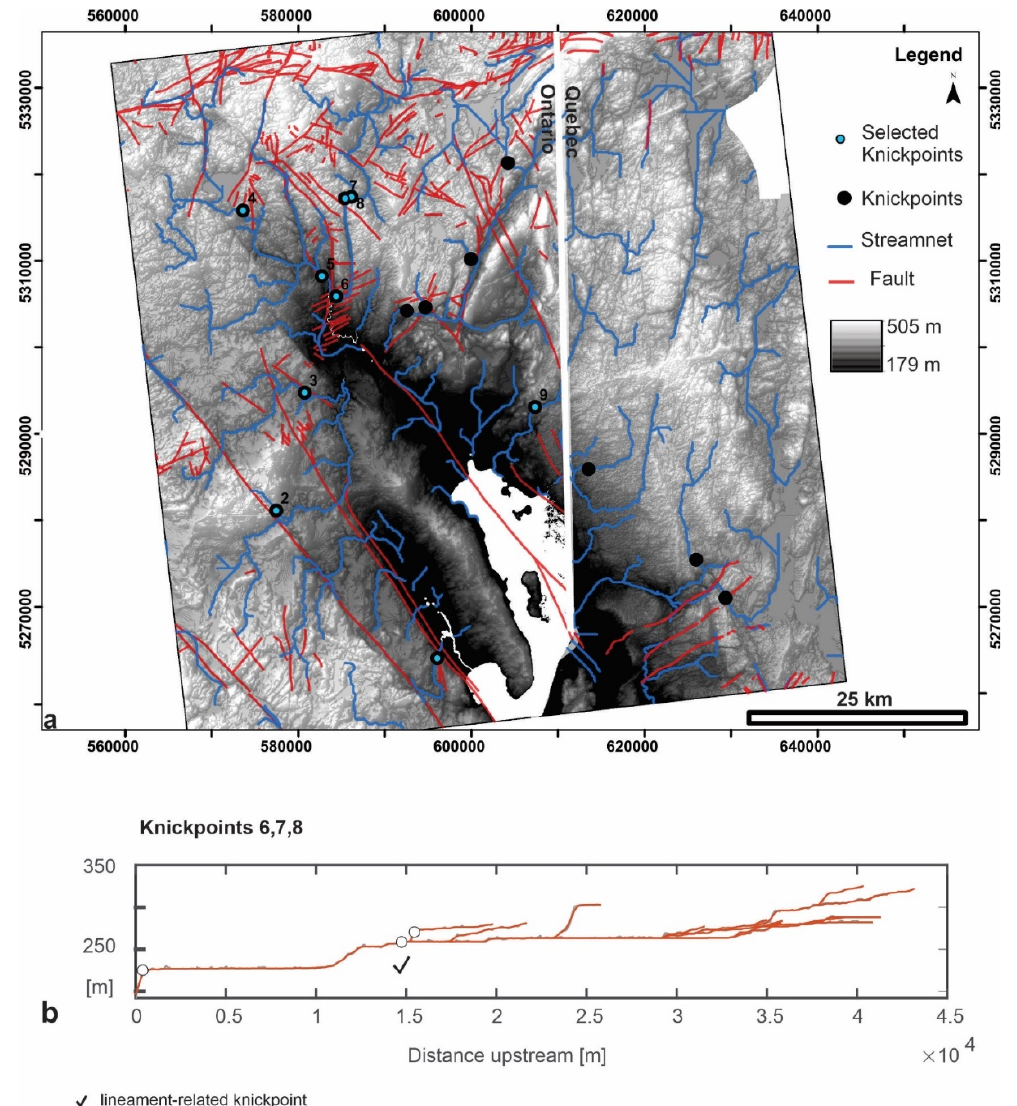
Figure 5. DEM and cross section of Subset 5 illustrating our analysis. ( a ) We identified 16 knickpoints (Table 1) at 30 m resolution within this subset (in black) but only 9 (in blue) were “selected” knickpoints because of their coincidence with HI Hot Spot areas (see explanation of the synthesis of our results in Section 4.5) and/or known structural features of the Temiskaming graben area; ( b ) profile for river on which knickpoints 6, 7, and 8 are found; knickpoint 7 is coincident with a known structural linear feature.